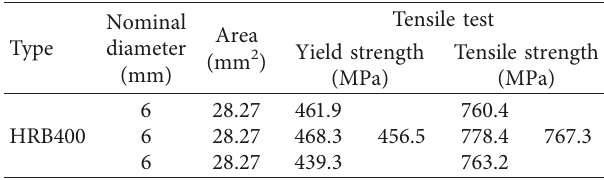
Table 3: Indices of mechanical properties of steel reinforcement.